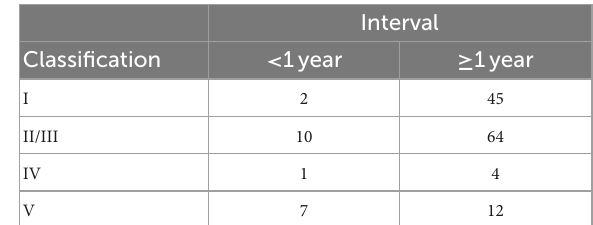
TABLE 3 Classification according to the time